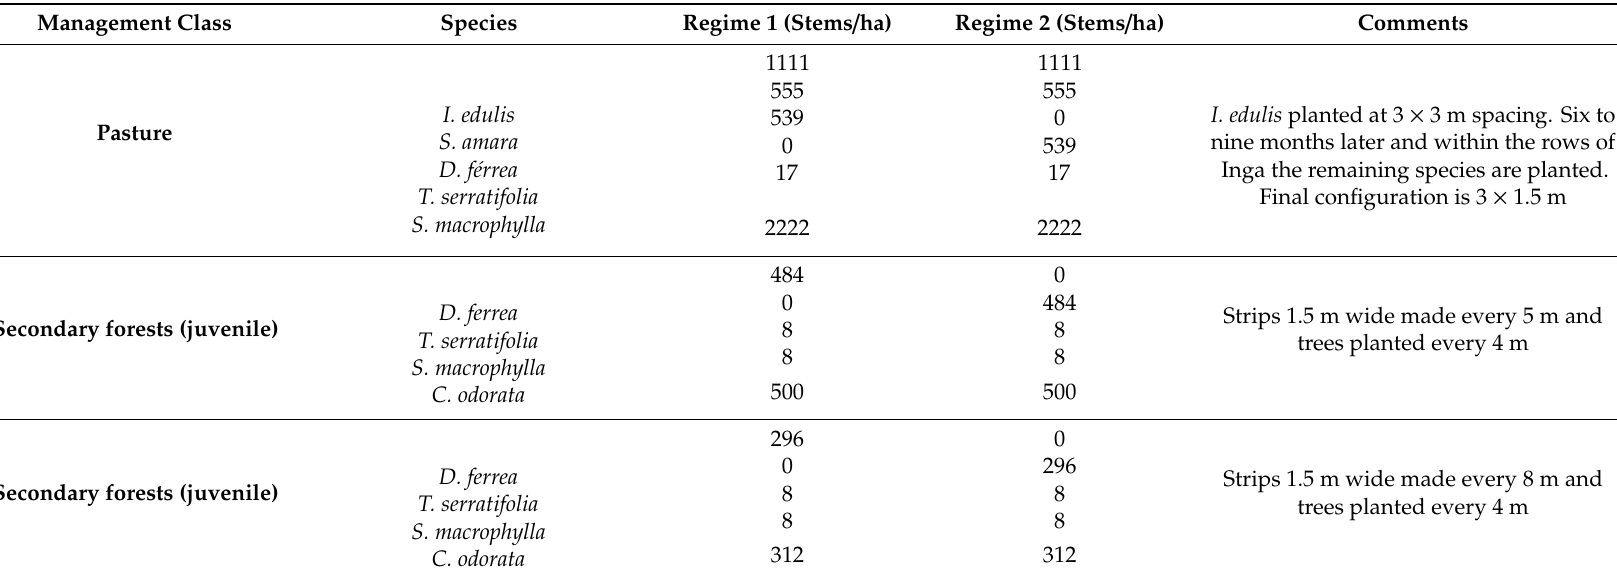
Table 1. The regimes for the reforestation of the pasture areas and the enrichment planting of the secondary